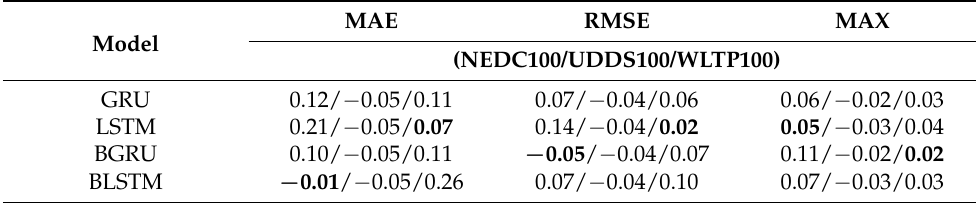
Table 5. The statistical results of scenario 3.